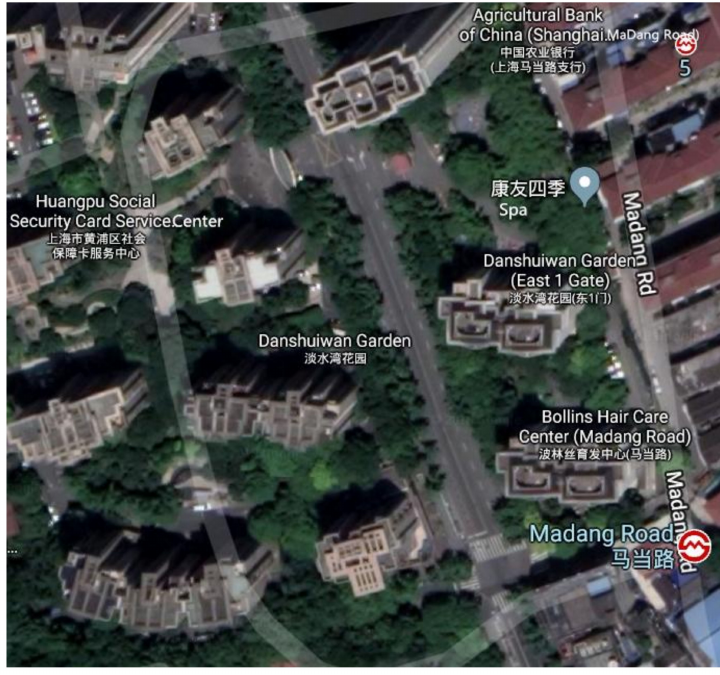
Figure 2. Simulated gated community.